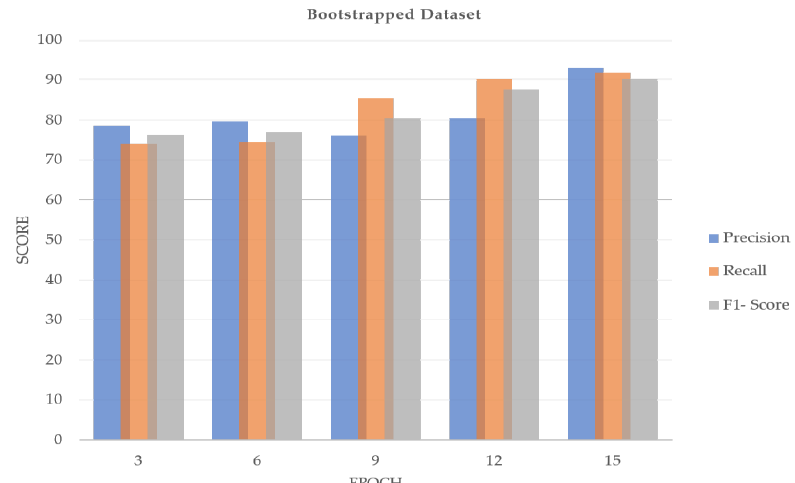
Figure 5. Bootstrapped dataset: relationship between number of epoch and performance.